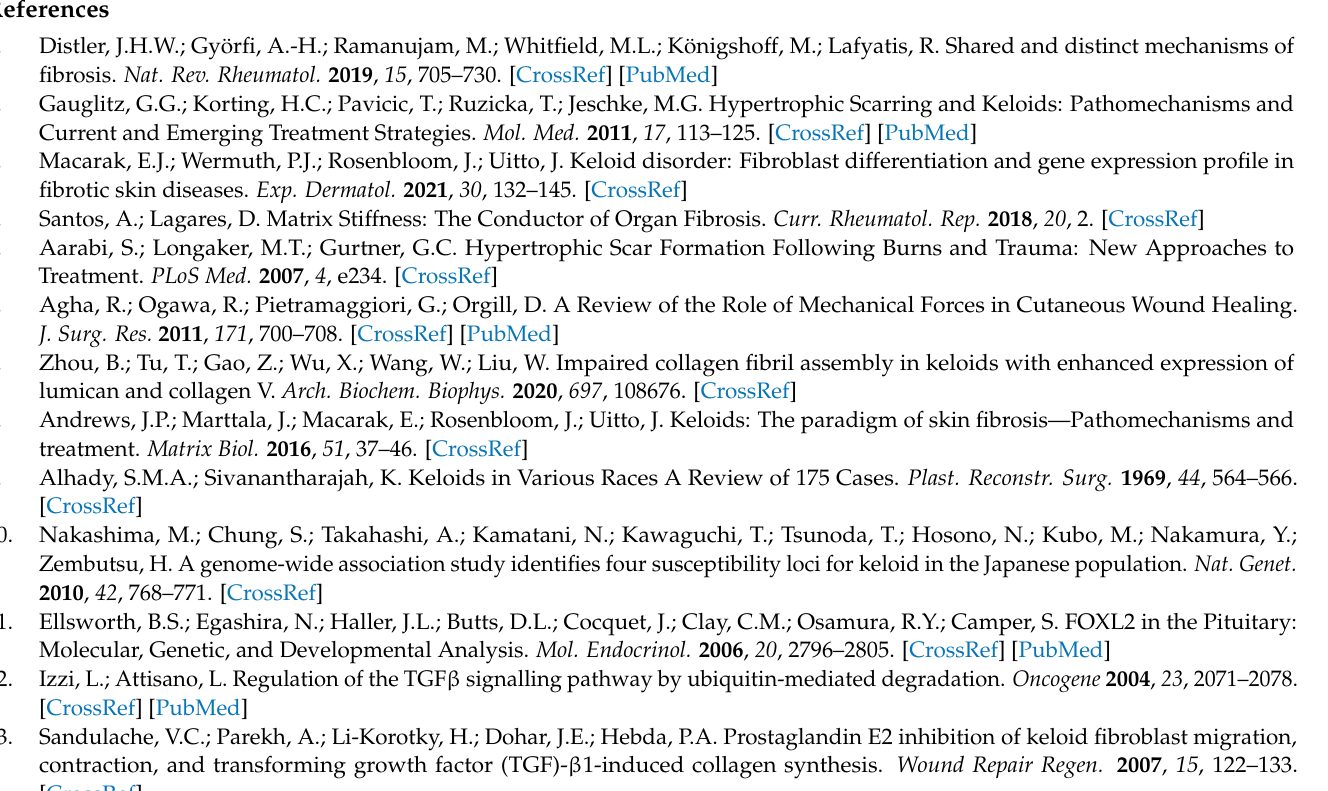
Figure A2. Tensile strain-stress curve of keloid with a linear regression line plotted; three reference lines represent the data known about the tendon, dermis layer of skin and hypodermis layer of skin.